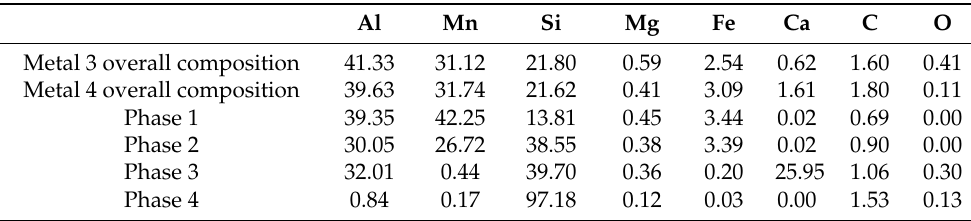
Table 3. Measured compositions for metals in exp. 3 and exp. 4